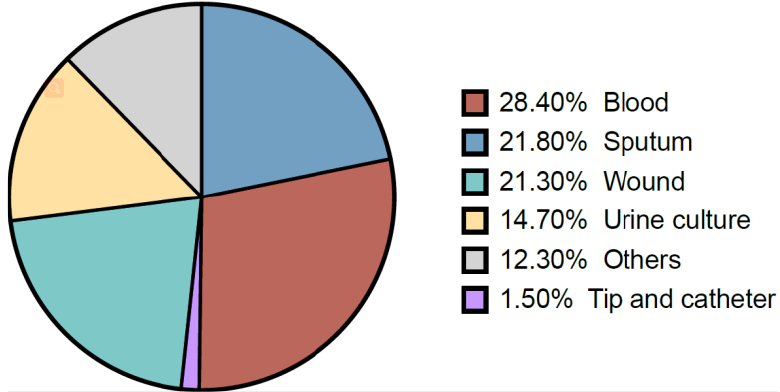
Figure 2. The proportion of different specimen types of K. pneumoniae. Table 2. The proportion of different specimen types from which K. pneumoniae was obtained.